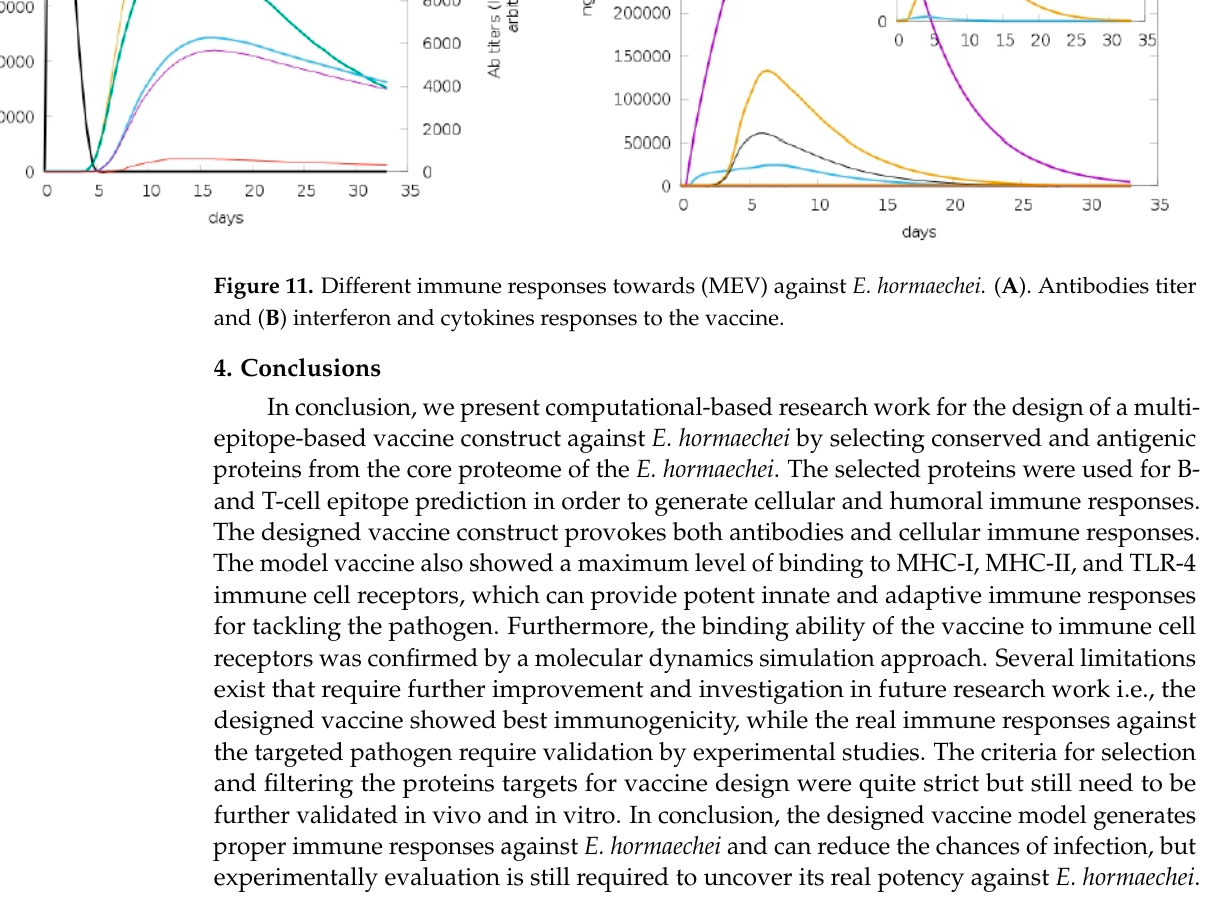
score. Table S3: Docking results of Vaccine-MHC-II complex. Table S4: Docking results of TLR-4 and Vaccine